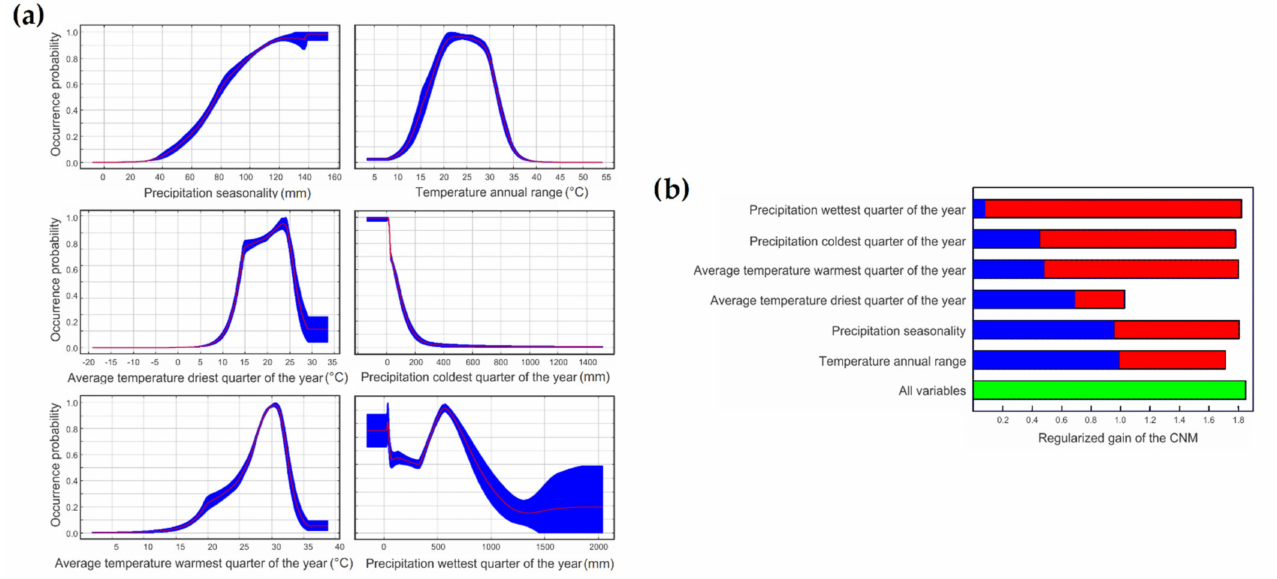
Figure 1. Response curves for each variable and Jackknife test. ( a ) The curves show how the predicted probability of occurrence changes as each environmental variable varies. ( b ) The Jackknife test indicates in blue the gain of the model from keeping only that variable, in red it shows the gain without the variable, and in green it shows the gain of the model with all the